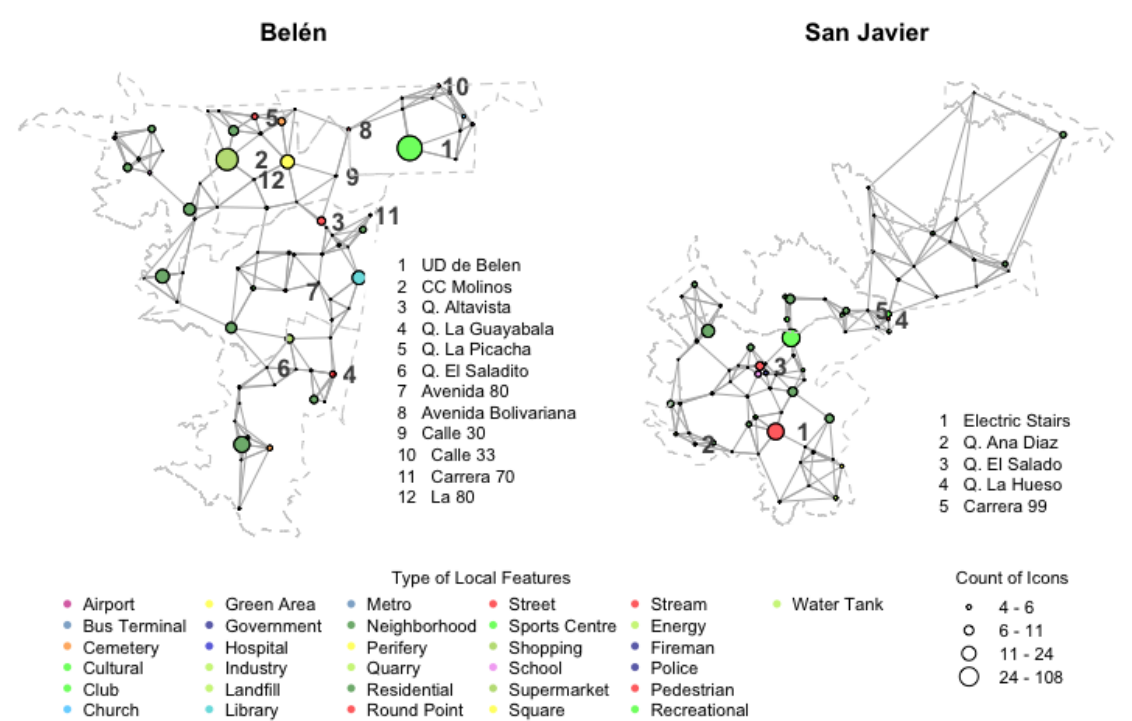
Figure 8. K-nearest neighbour graphs of the Medellín group of sampled communities. space, including their interactions with the city network.